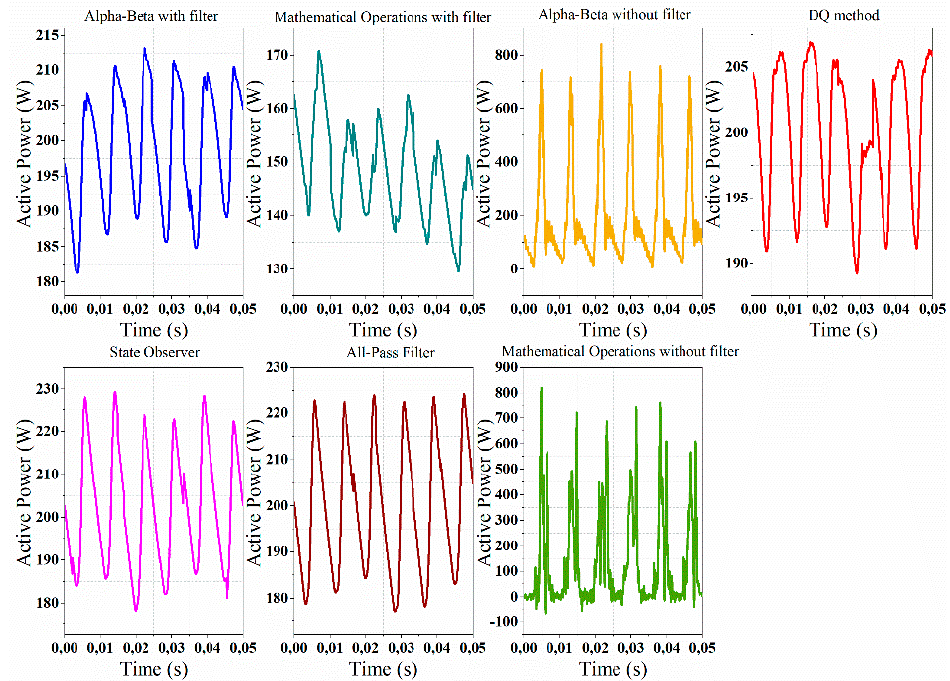
Figure 16. Active power calculation with all methods at the fundamental frequency—non-linear load.